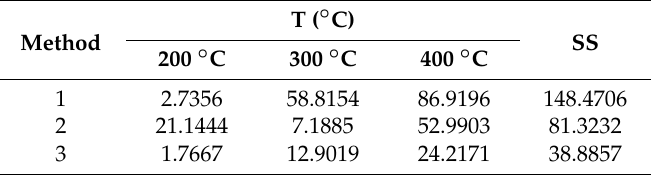
Table 16. Analysis of the variance of the cutting force determined by